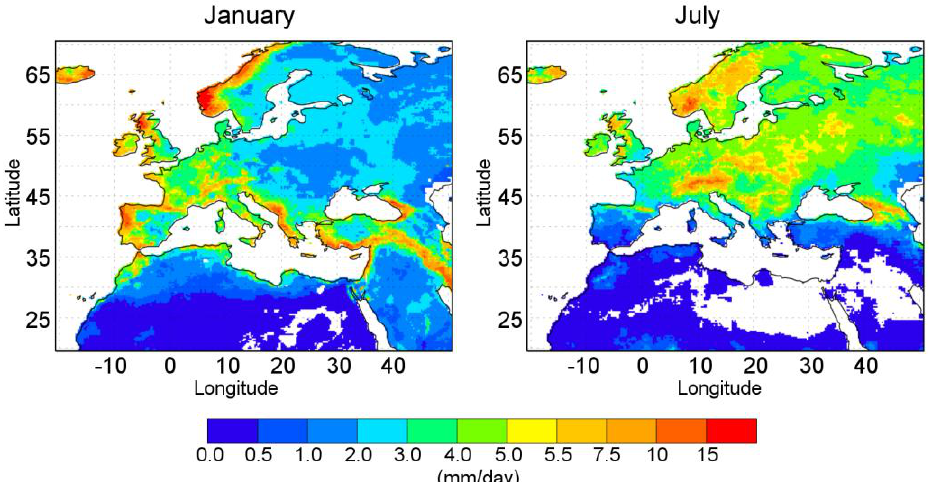
Figure 3. Mean precipitation for each grid point for the identified five years with the highest value of precipitation (MSWEP-extreme) for January (right panel) and July (left panel). Results are obtained from the MSWEP precipitation dataset, which considers a 36-year temporal period (1980–2015). Units in mm/day. White color over continents indicates where the MSWEP database does not report values during any of the five months computed.